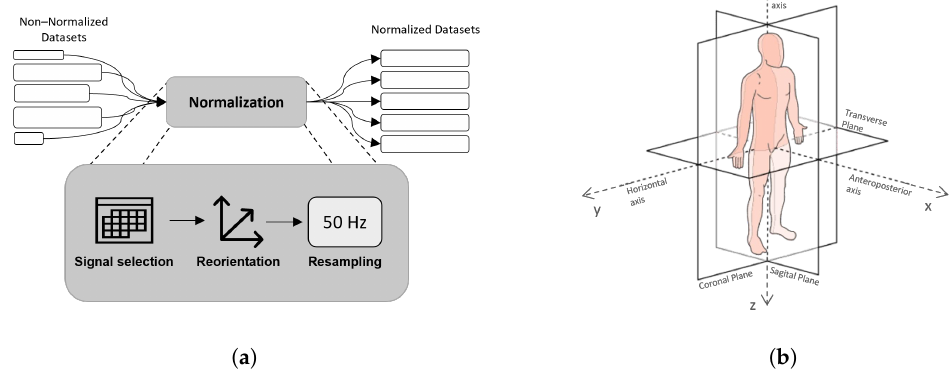
Figure 1. ( a ) Normalization process steps implemented in order to normalize the public datasets for ADL recognition. ( b ) Desired sensors orientation. The inertial sensors have to be located on the subjects’ waist. The arrows and letters x, y and z indicate the positive direction of the anteroposterior, mediolateral and longitudinal axes, respectively.